Question: What kind of plot is shown here?
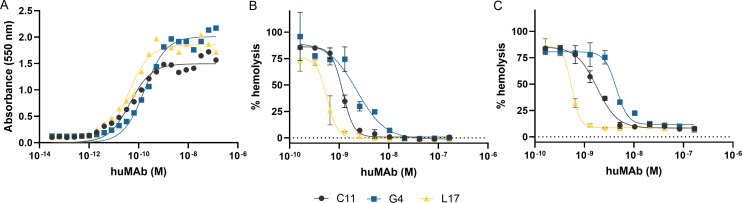
Answer: bar